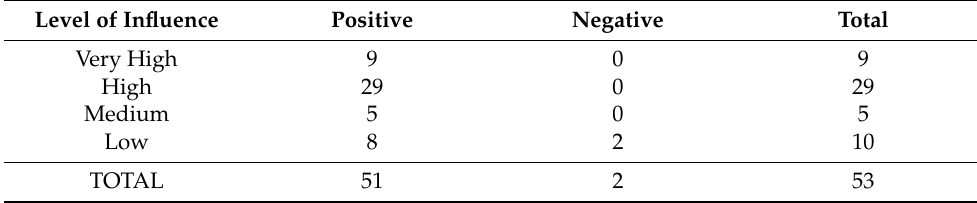
Table 9. Number of Categories by Level of Influence (CIMVDL). Source: the authors.